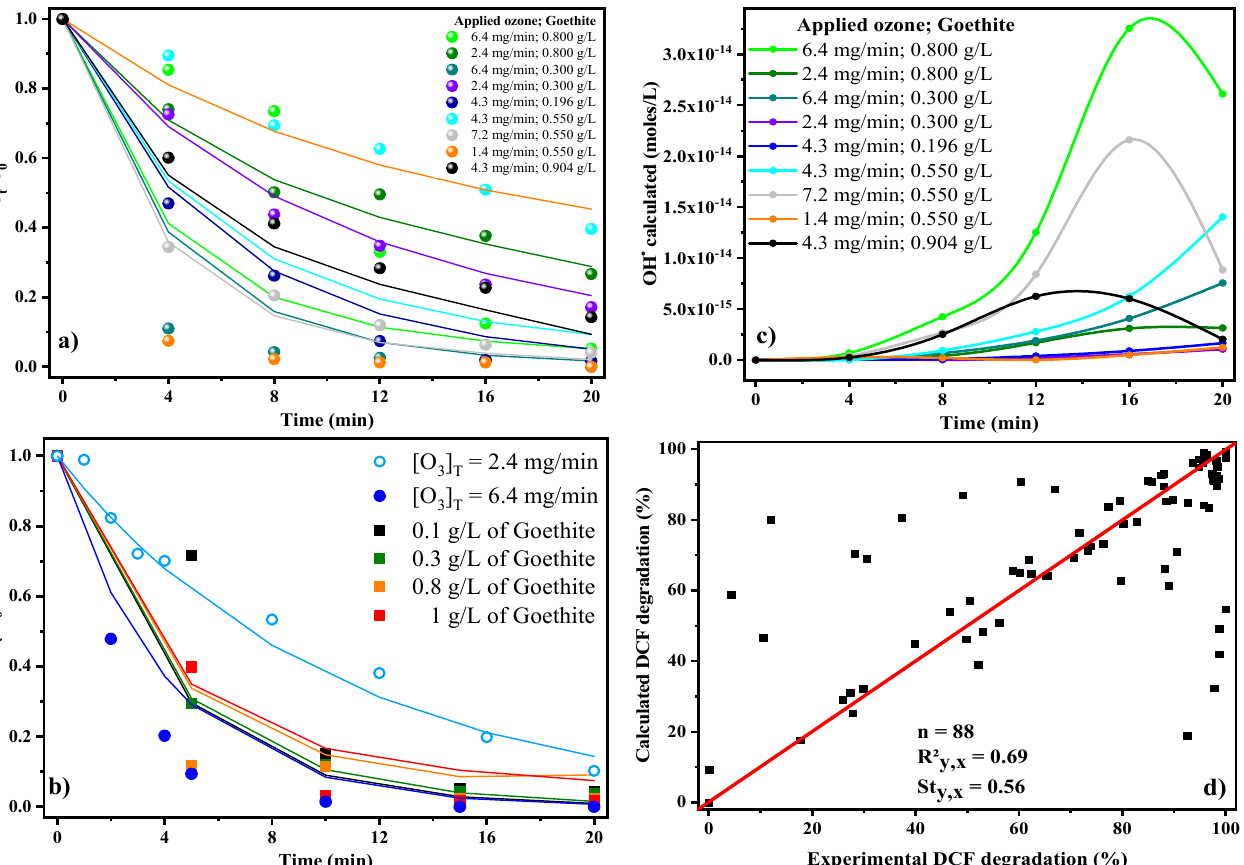
Figure 5. Prediction of experimental data using the kinetic model elemental reactions for ozonation and catalytic ozonation ( a , b ), moles of OH • calculated ( c ), and correlation of experimental and calculated data ( d ). The percentage correlation (R 2 = 0.69) and percentage standard deviation (St y,x =